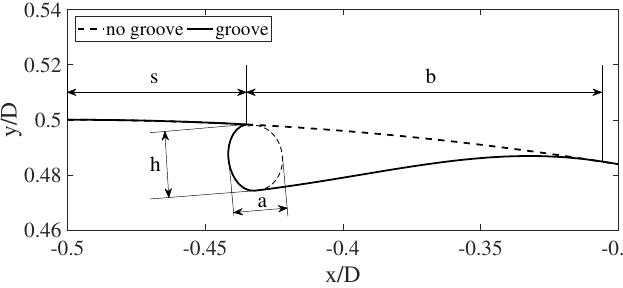
Figure 2. Groove geometry and main